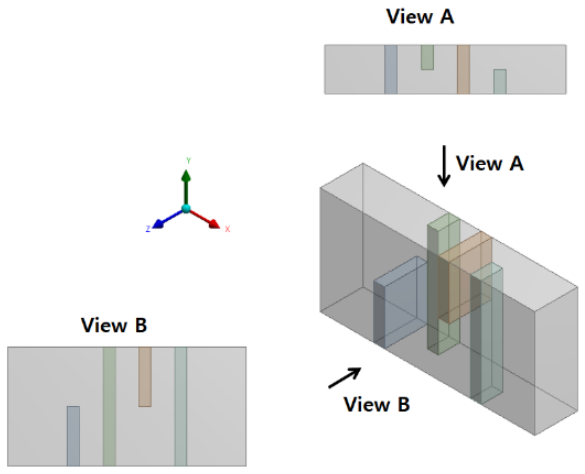
Figure 1. Schematic diagram of the four-baffle arrangement within a mixing unit.